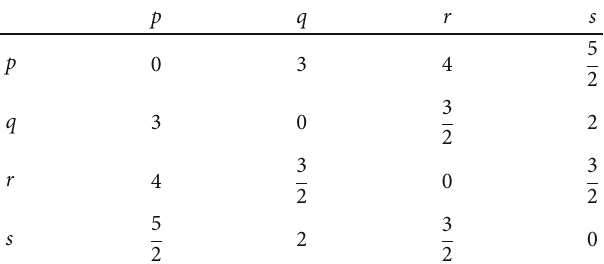
Table 1: Table of metric d